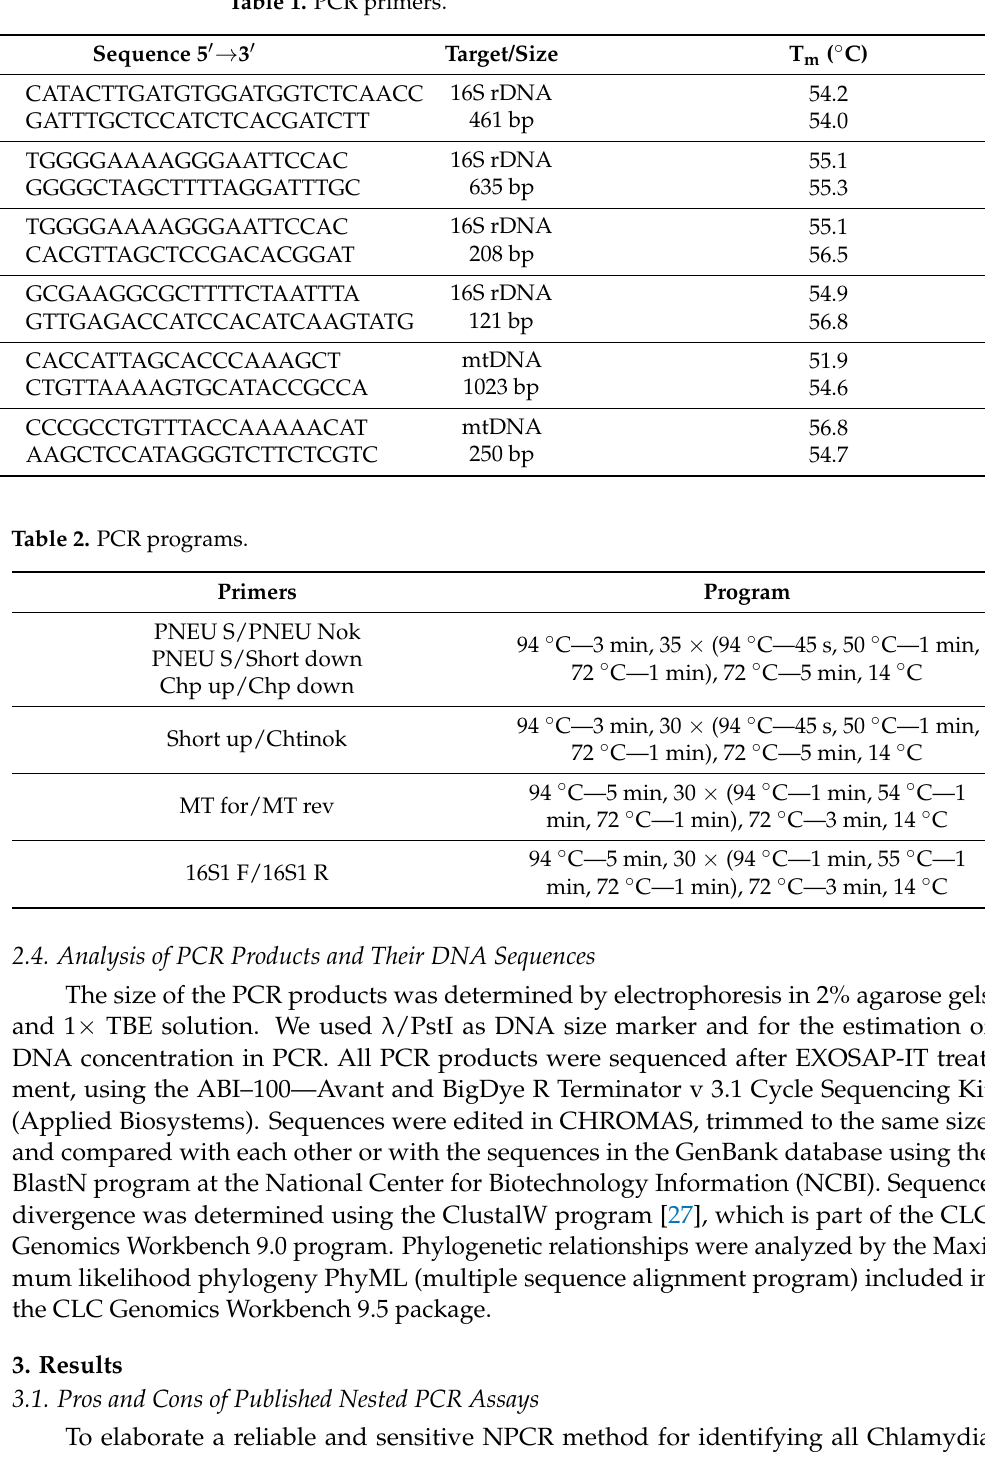
Table 1. PCR primers.